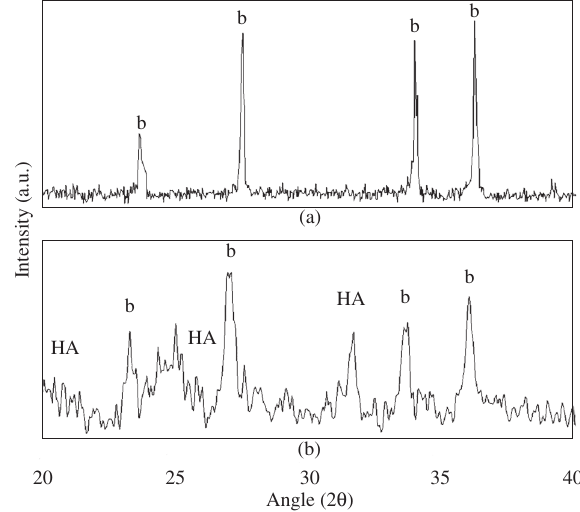
coating.Template Figure 3. Diffuse reflectance infrared Fourier transformed (DRIFT) spectra of a silicon nitride sample with hydroxyapatite